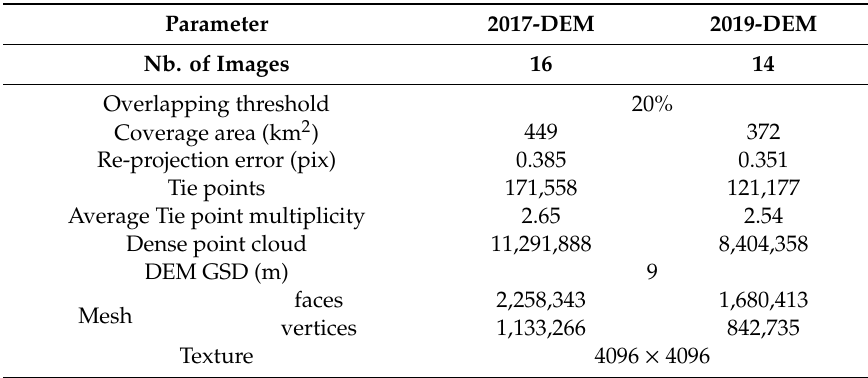
Table 2. PlanetScope DEM